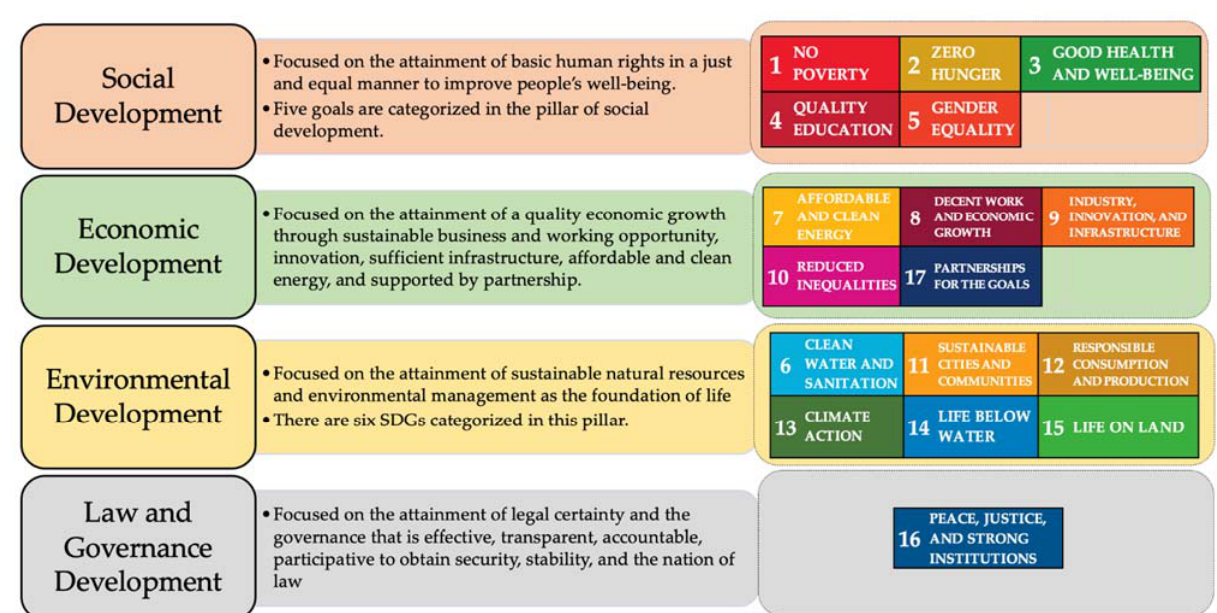
Figure 3. Four Sustainable Development Pillars in Indonesia (Modified from BAPPENAS [49]).